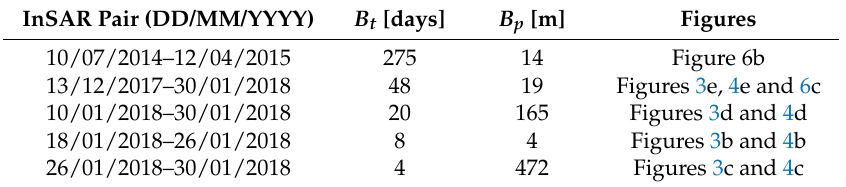
Table 2. Dates and perpendicular ( B p ) and temporal ( B t ) baselines of the COSMO-SkyMed InSAR pairs used for the analysis of the December 2014 and January 2018 events that occurred at the Nasca